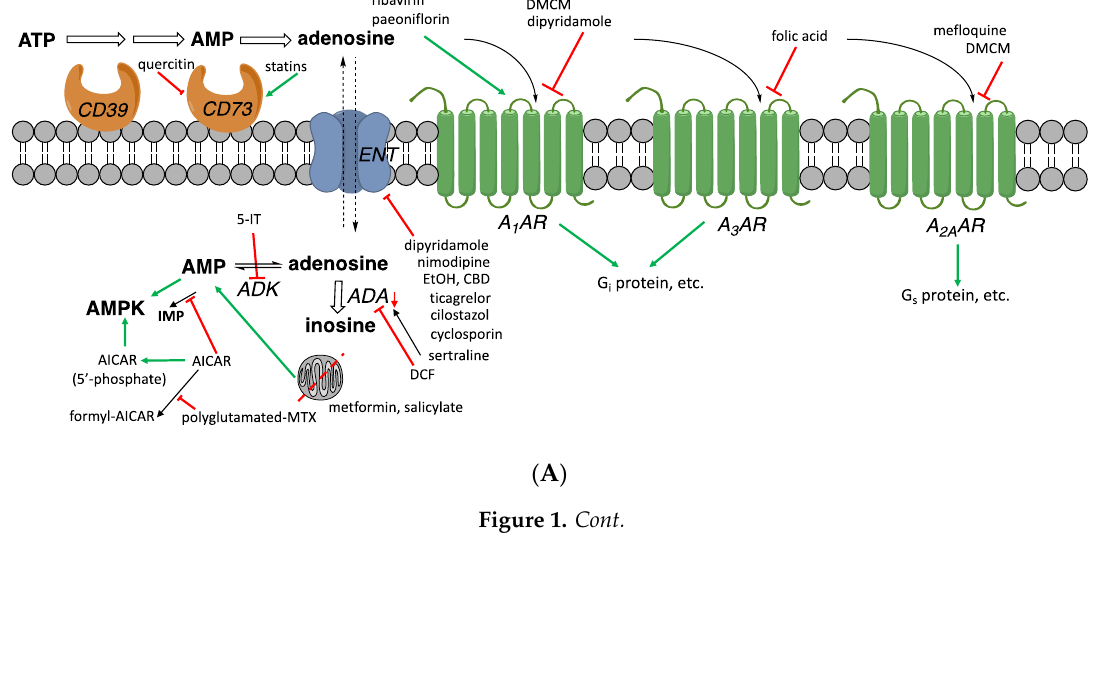
glucocorticoids d